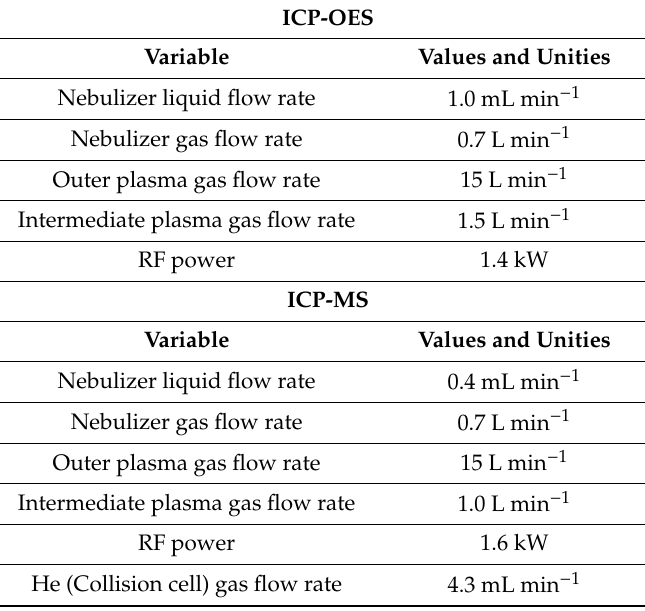
Table 5. Inductively coupled plasma optical emission spectrometer (ICP-OES) and inductively coupled plasma mass spectrometer (ICP-MS) instrumental